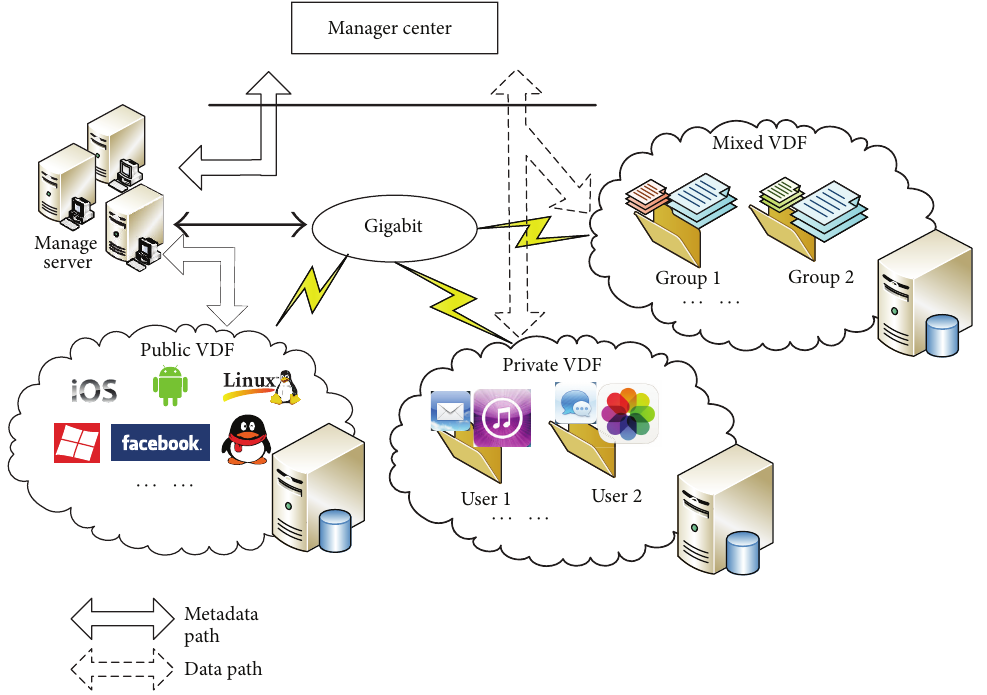
Figure 6: Distributed storage of resources and